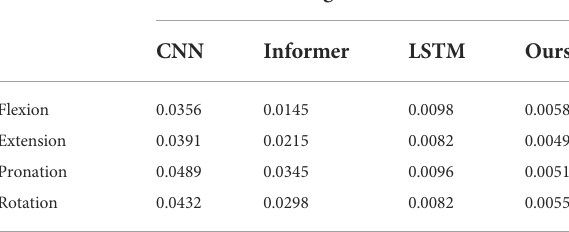
TABLE 2 Prediction results of different features for each subject.